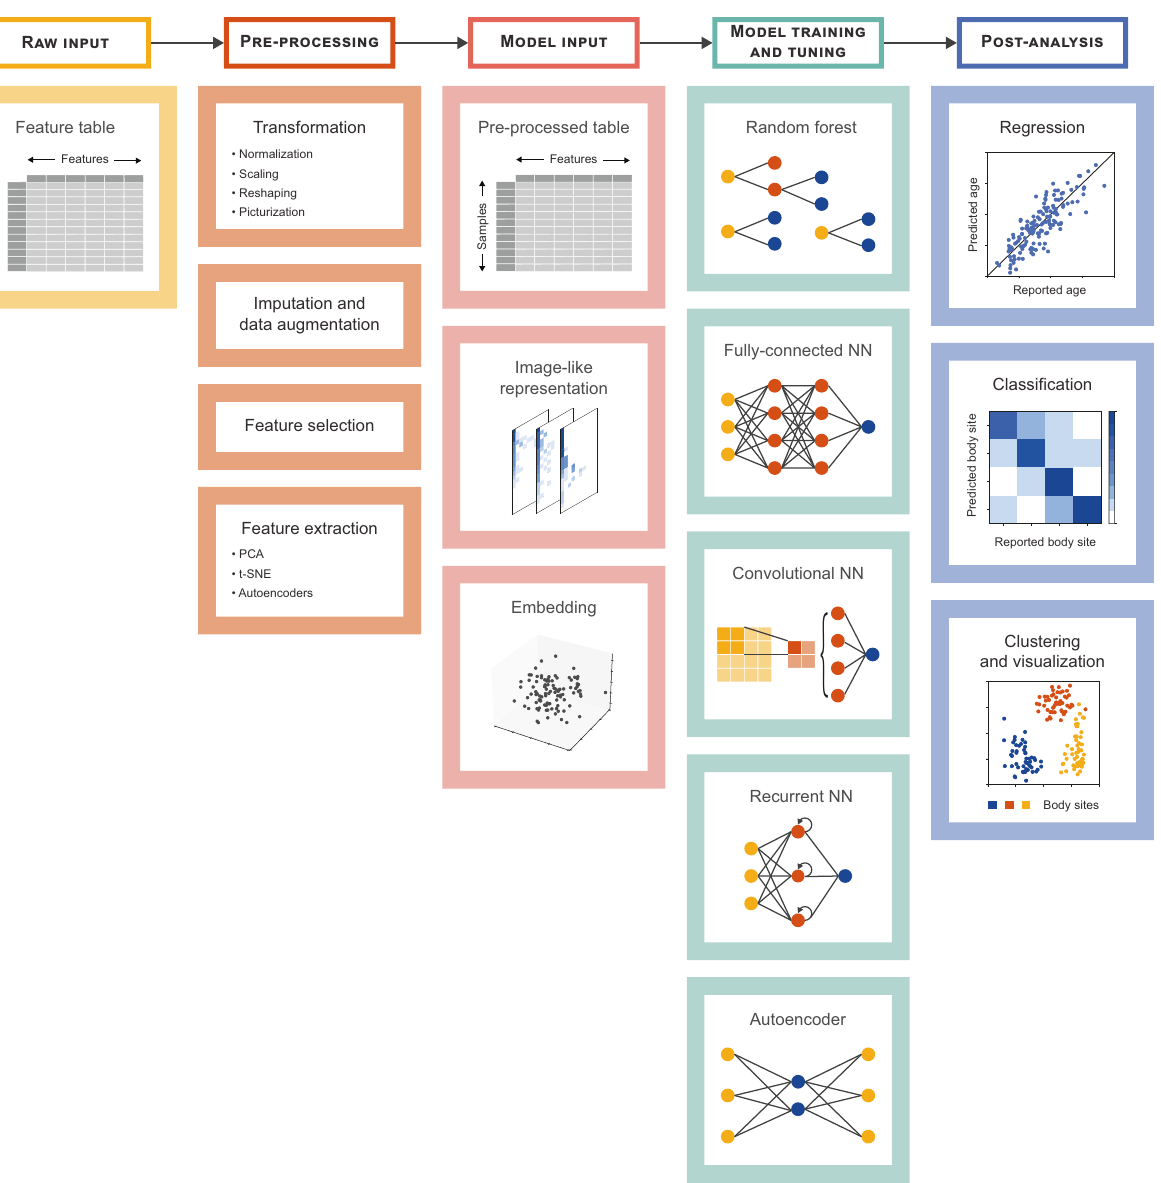
Fig. 2 Key steps of ML-assisted microbiome analysis. Generally, analysis begins with a feature table describing the functional or taxonomic pro fi le of a microbiome. As part of the pre-processing step, this table can be transformed, imputed, or augmented, among other processes. The outcome of pre-processing can be tabular data or a set of image-like representations or embeddings per sample. The next step entails training and tuning ML or DL models, such as random forests, fully-connected neural networks, convolutional neural networks, recurrent neural networks, and autoencoders. Finally, the results help to elucidate the link between the microbiome composition and a continuously- (regression) or discretely-described (classi fi cation, clustering, and visualization)